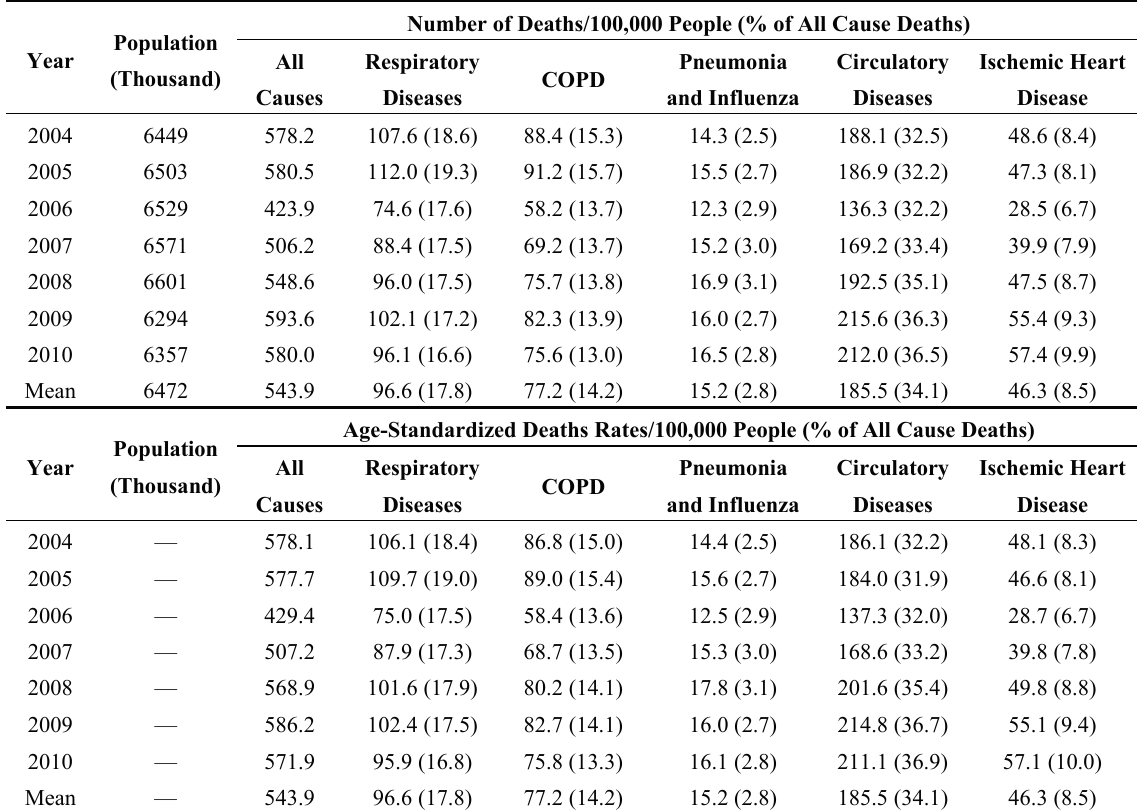
Table 1. Annual death rates (per 100,000 people) by all-cause death in Southern China,